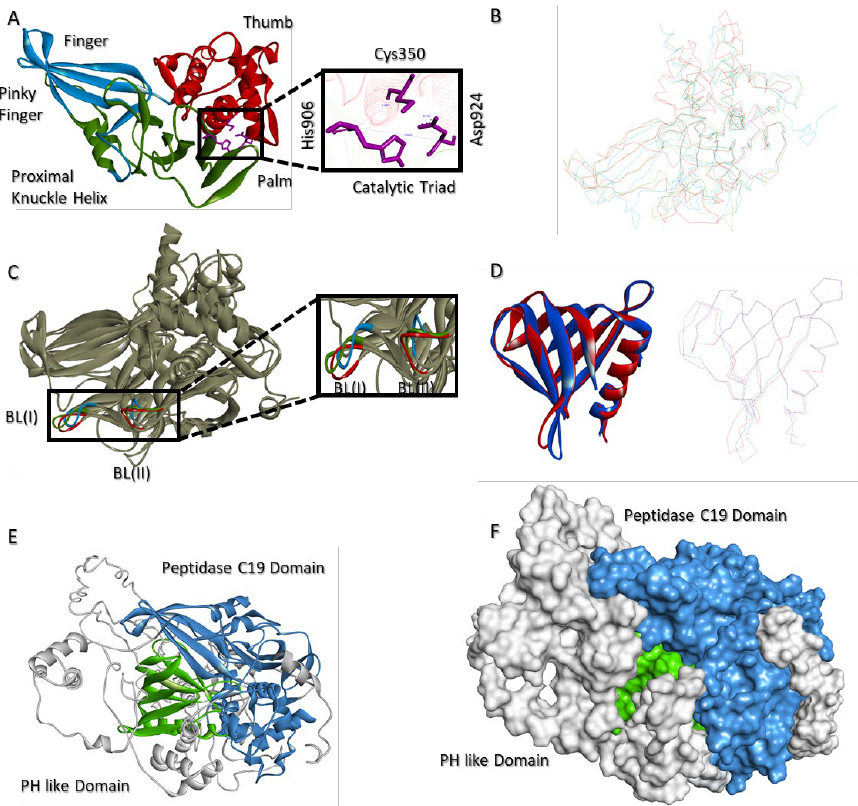
Figure 8. Structure of USP37. ( A ) Ribbon diagram of the C19 domain of USP37 is shown, where structural subdomains are labeled and represented with different colors along with a catalytic triad. ( B ) Superimposition of the C α backbone of the C19 domain of USP37 (red) over the C19 domain of USP12 (blue) and USP46 (green). ( C ) Superimposition of blocking loops I and II of USP37 (red) over the BL of USP12 (blue) and USP46 (green) in the full C19 ribbon conformation. ( D ) Superimposition of the structurally resolved PH domain (blue) over the modeled PH domain of USP37 in a full-length model (red) in ribbon and C α wire conformations. ( E ) Full-length ribbon structure and ( F ) surface topology of USP37, where domains are labeled and colored differently.